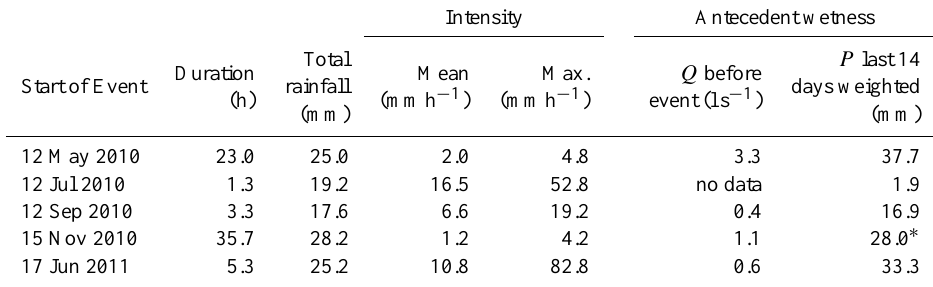
P last 14 days weighted